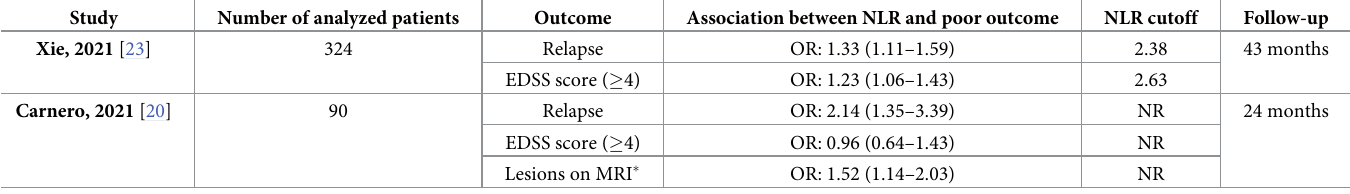
Table 2. Characteristics of the included studies evaluating the prognostic use of the neutrophil-to-lymphocyte ratio (NLR) for outcomes in neuromyelitis optica spectrum disorder (NMOSD). Study